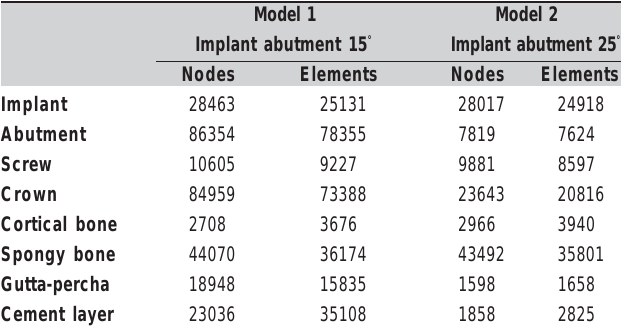
Table 2: Number of nodes and elements after meshing models’ components.